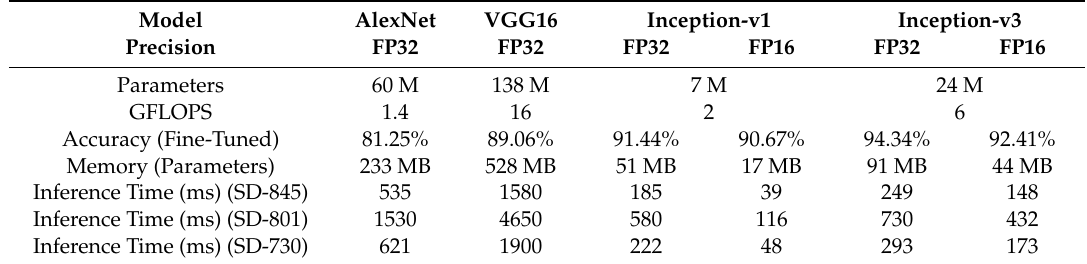
Table 7. Computational and memory requirements for various CNNs.